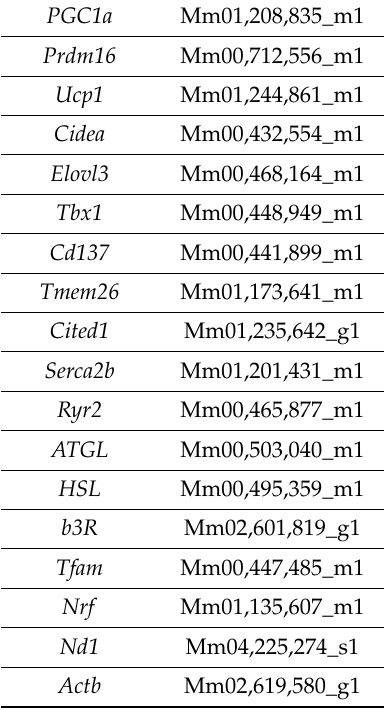
Table 1. List of TaqMan ®